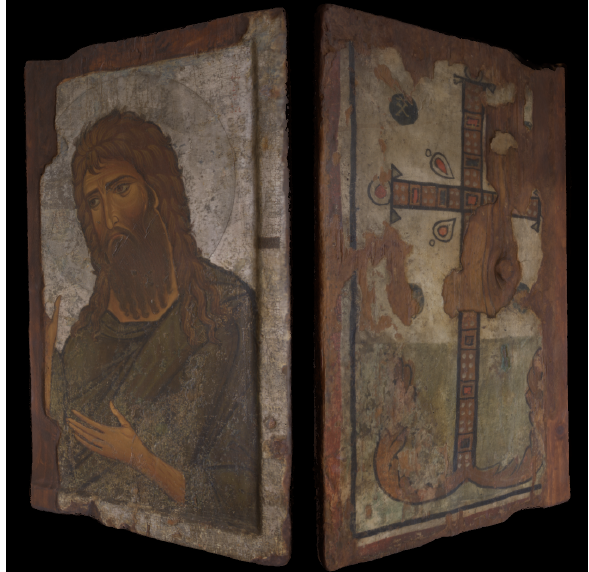
Figure 1: Earliest Icon from Asinou: Saint John the